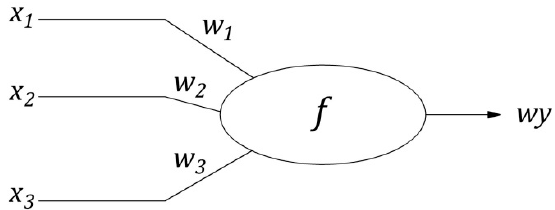
Figure 9. The scheme of a neuron (node) with three inputs and one output where x 1 , x 2 , x 3 are input signals from the previous ANN’s layer, w 1 , w 2 , w 3 are their weights, wy the value of activation function i.e., outgoing signal from the node to consecutive layer or output of the net [28].